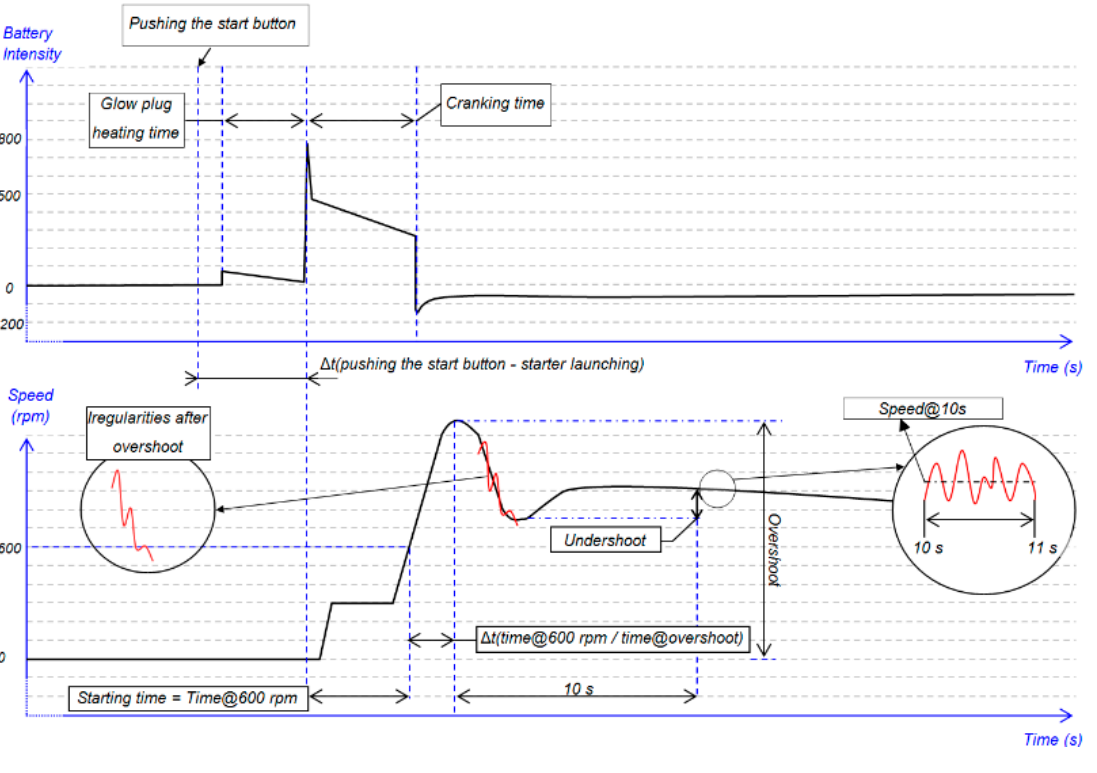
Figure 1. Engine behavior during cold start.